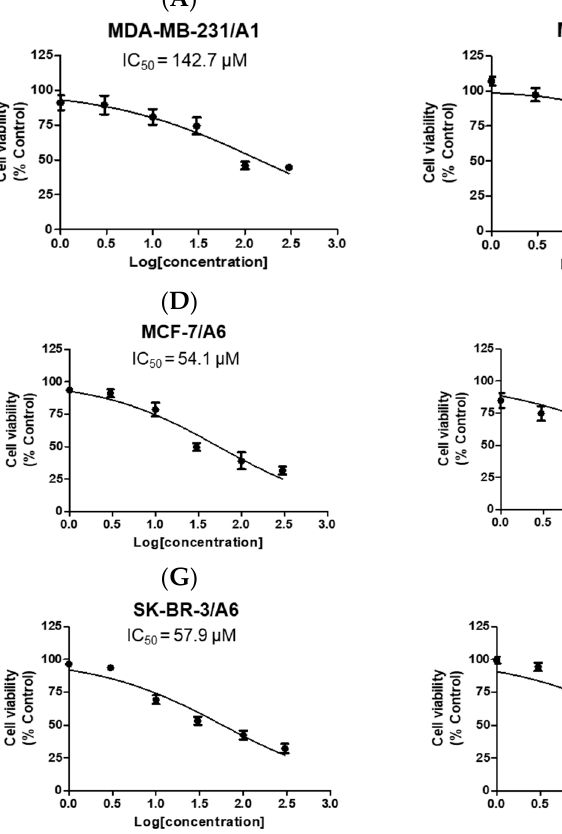
Figure 3. Concentration-dependent effects of the selected compounds on the viability of breast cancer cells. ( A ─ C ) Effects of A1 , A6 , and SLC-0111 on the viability of MDA-MB-231 cells. ( D ─ F ) Effects of A6 , A15 , and SLC-0111 on the viability of MCF-7 cells. ( G ─ I ) Effects of A6 , A15 , and SLC-0111 on the viability of SK-BR-3 cells. Cells were treated with the indicated compounds at 1, 3, 10, 30, 100, and 300 μ M for 48 h under CoCl 2 -induced hypoxic condition. Control cells were treated with the media containing 0.6% DMSO instead. Cell viability was determined by MTT assay as described in the Materials and Methods. The viability of vehicle (DMSO)-treated control cells was defined as 100%, and the cell viability was expressed as a percentage of the control measured in the vehicle-treated cells in each cell line. Data are displayed as mean ± SEM from three independent experiments. IC 50 values were calculated using GraphPad Prism, as described in the Materials and Methods.